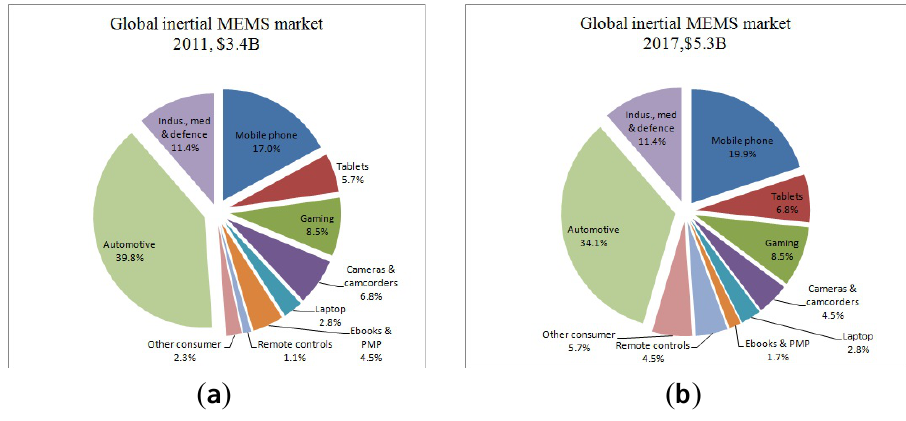
Figure 43. Inertial MEMS products situation. ( a ) Global inertial MEMS market in 2011. ( b ) Global inertial MEMS market in 2017. ( c ) Diffusion of MEMS gyroscopes in mobile phone and